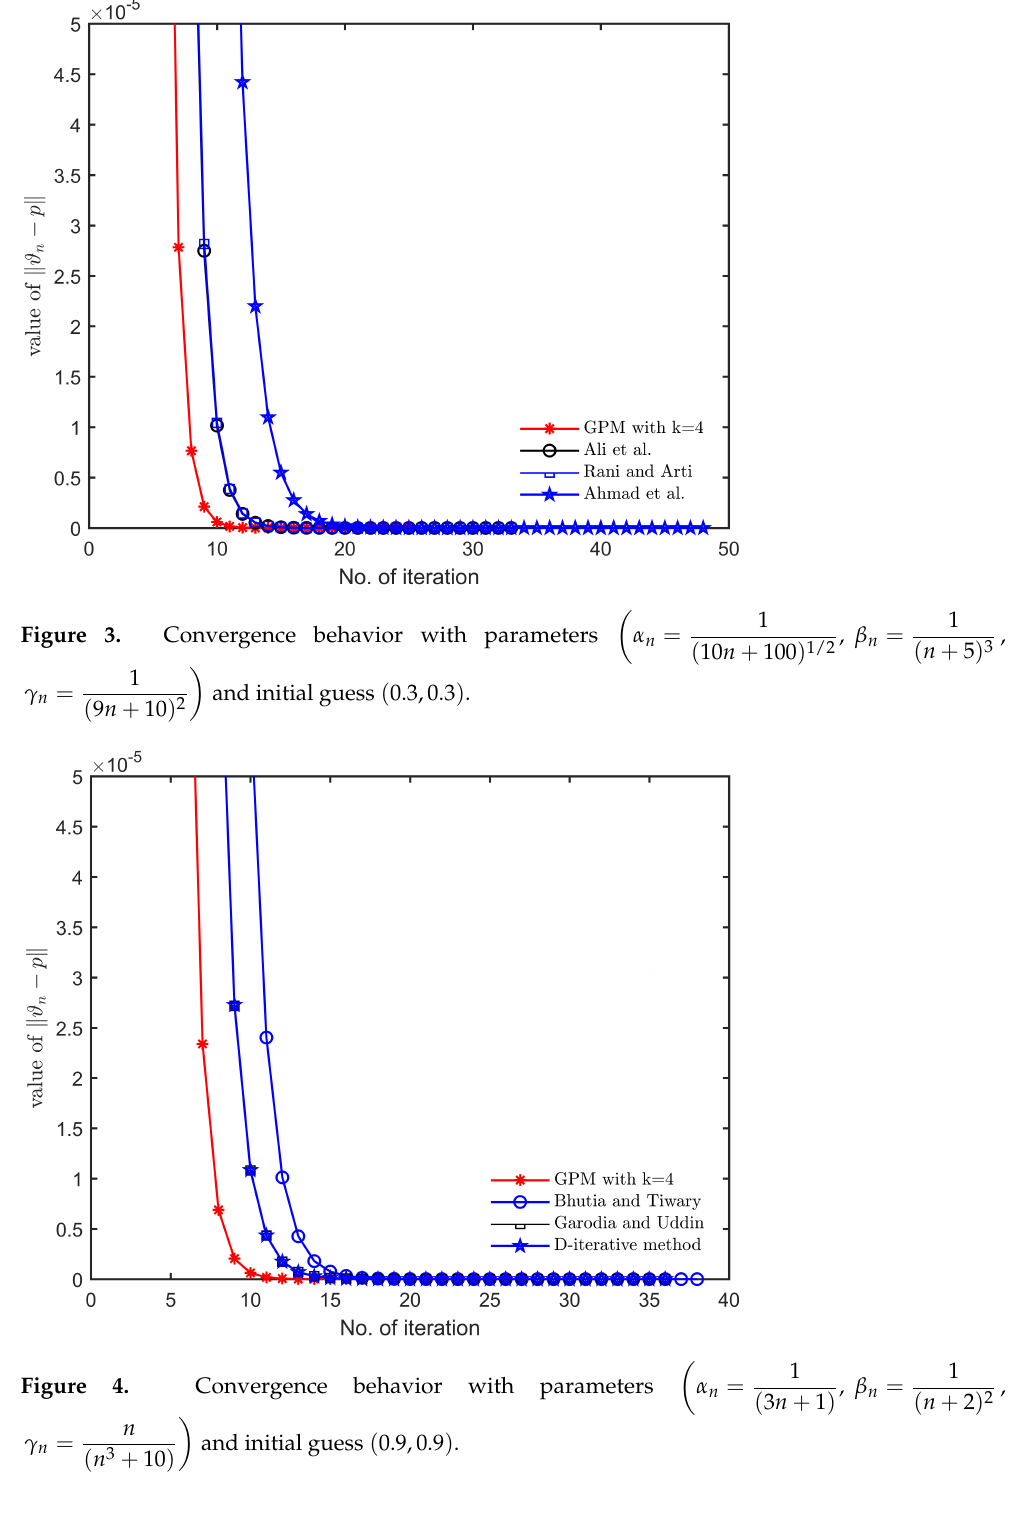
Figure 4. Convergence behavior with parameters (cid:19) n γ n = and initial guess ( 0.9,0.9 ) ( n 3 + 10 )